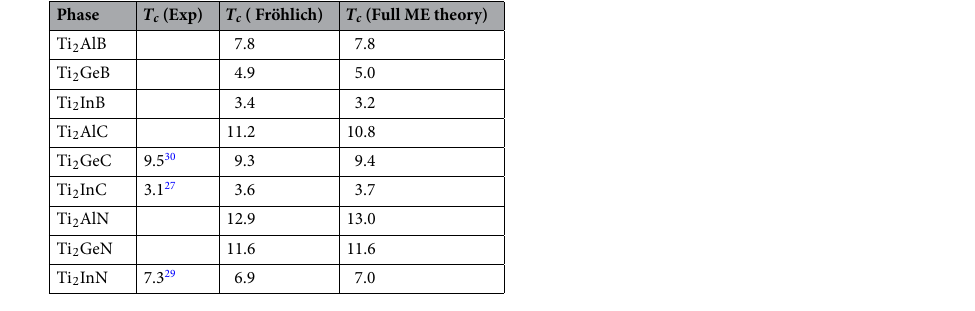
Table 1. Superconducting temperature values ( T c in K) of experimental, predicted through simple Fröhlich model and calculated by Migdal–Eliashberg (ME) theory for Ti 2 AX (A: Al, Ge and In, X: B, C and N).